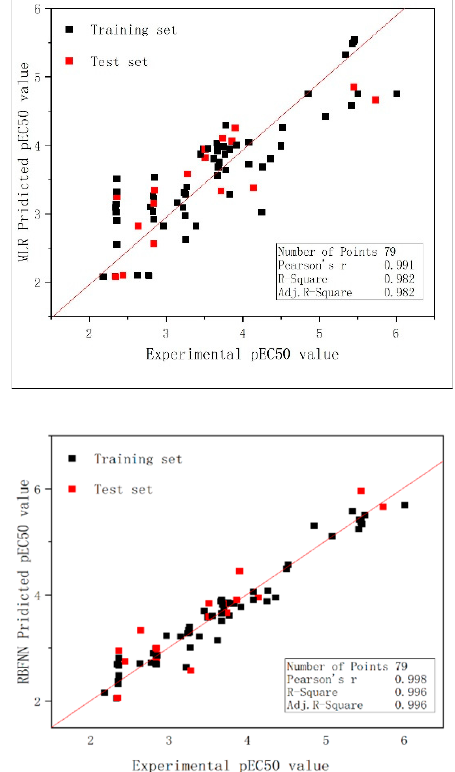
Figure 3. Plot of the predicted versus experimental log (EC50), including the training and test sets, from the MLR model and RBFNN model.